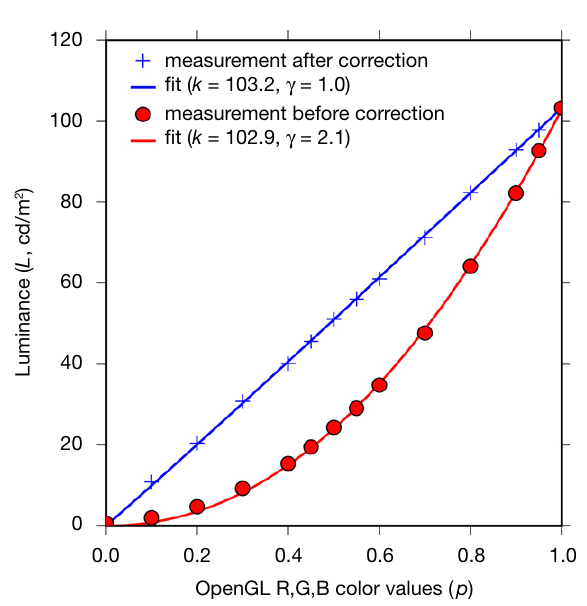
Figure 6 | Luminance output of a CRT display is made linear with respect to commanded pixel value. Color values specifi ed in OpenGL units produce non-linear luminance relationship on an uncorrected display (red circles), but a corrected display has a linear relationship between specifi ed and actual luminance (blue crosses). Lines are linear least squares fi ts to Eq. 1, Section “Precise Control of Color and Luminance: Results of Luminance Calibration,” with coeffi cients given in the